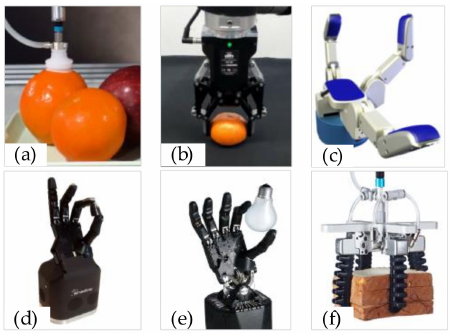
Figure 6. Di ff erent structures of grasper: ( a ) sucker [48], ( b ) two-fingered grasper [49], ( c ) three-fingered grasper [50], ( d ) four-fingered grasper [51], ( e ) five-fingered grasper [51], ( f ) soft grasper